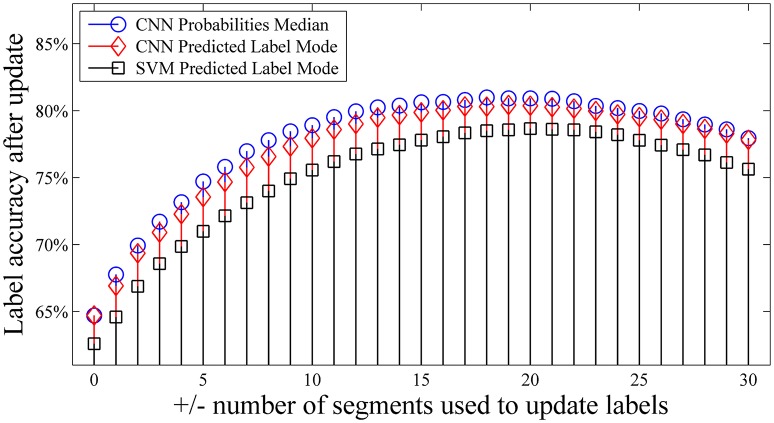
Effects of number of segments used for label updating (Equations 1–3). The data in the first repetition was used to train the classifiers, and was tested with the second repetition. Accuracy was calculated by comparing the updated labels against the ground truth for the first 10 subjects.